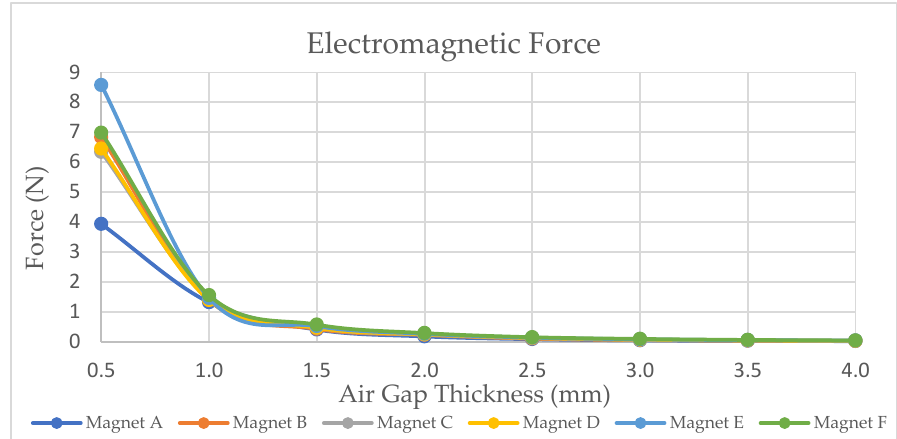
Figure 6. Electromagnetic force reaction due to air gap thickness by magnet size.